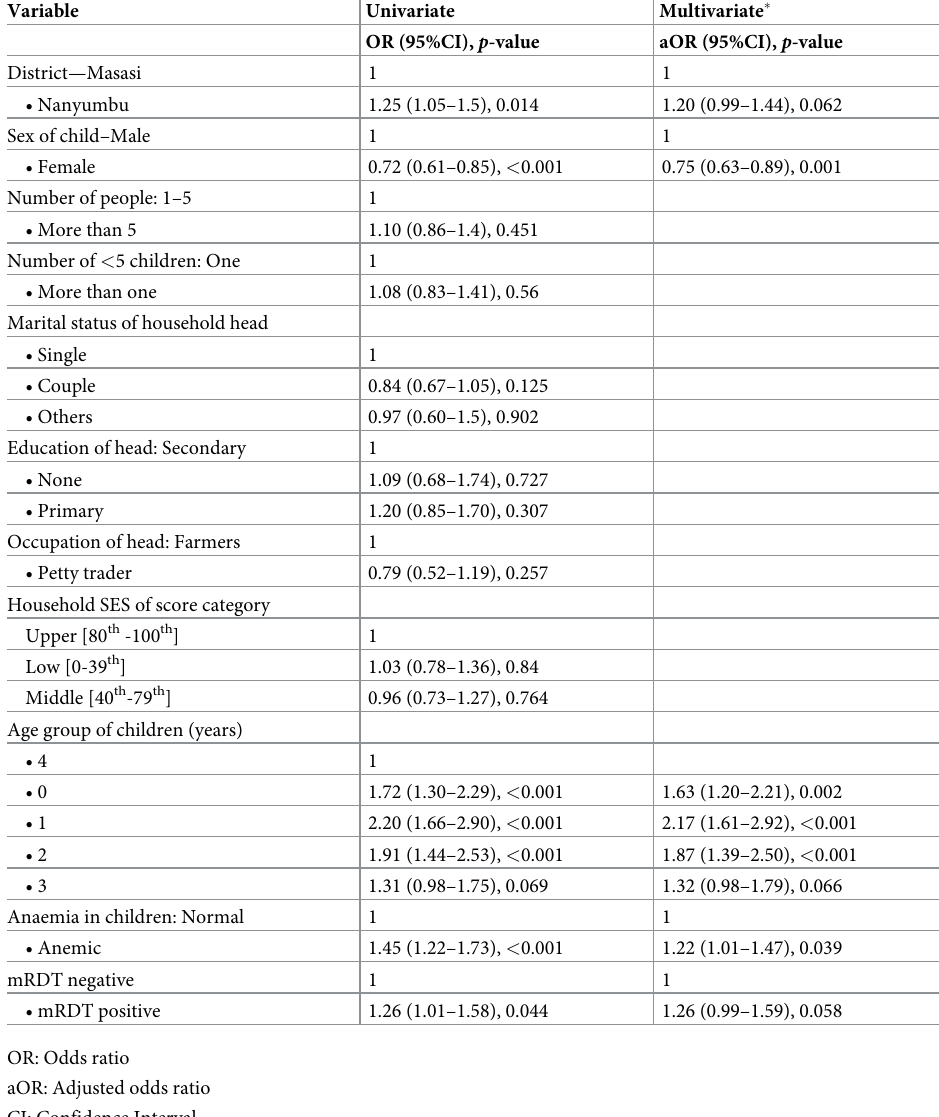
Table 5. Relationship between socioeconomic factors and undernutrition using logistic regression models.